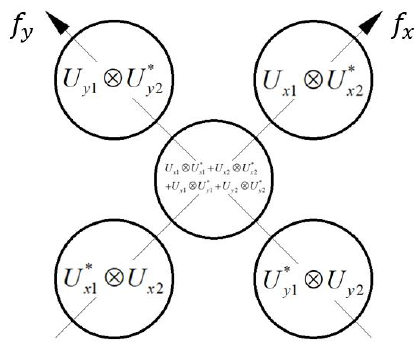
Figure 4. Schematic diagram of the spectrum distribution of the speckle pattern in the frequency domain .